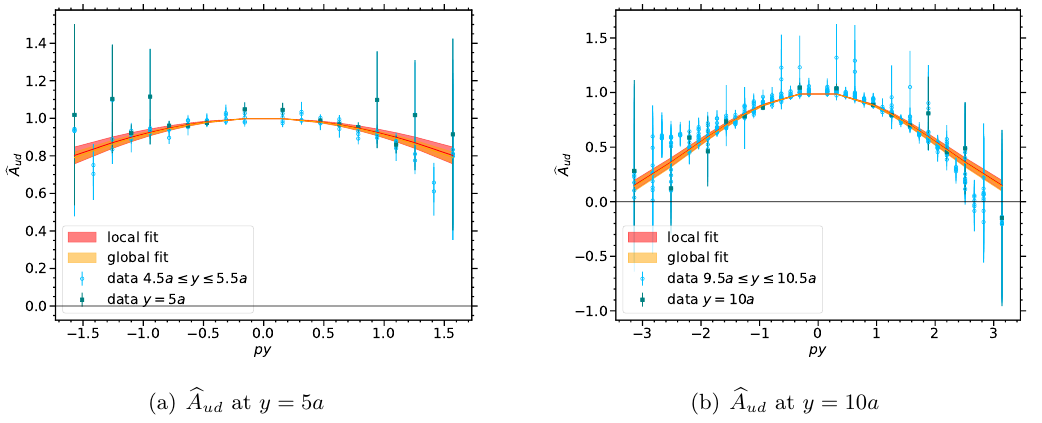
Figure 27 . Data and fits of the py dependence of b A ud for different y . The meaning of dark and light points is as in figure